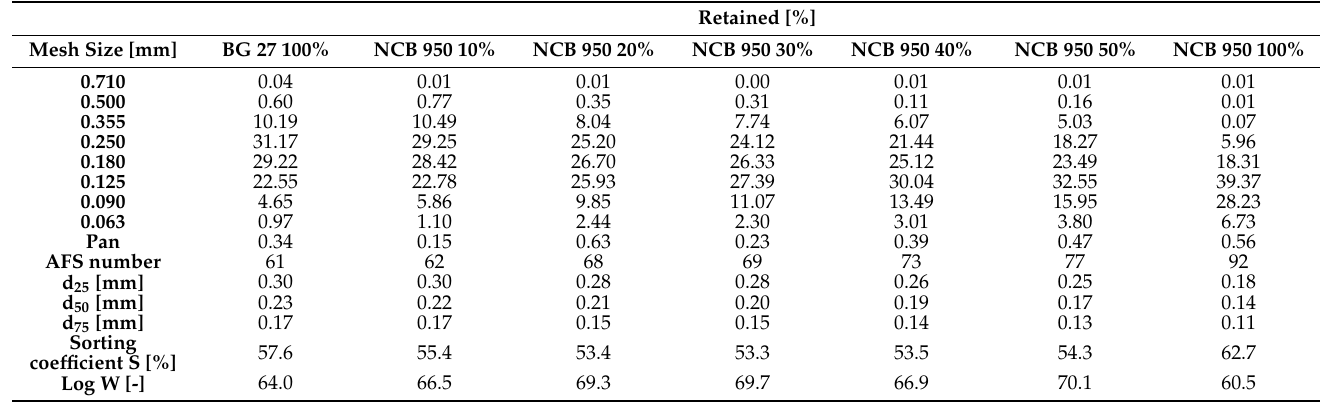
Table 3. Particle size distribution and basic parameters of test sand specimens for NCB 950.